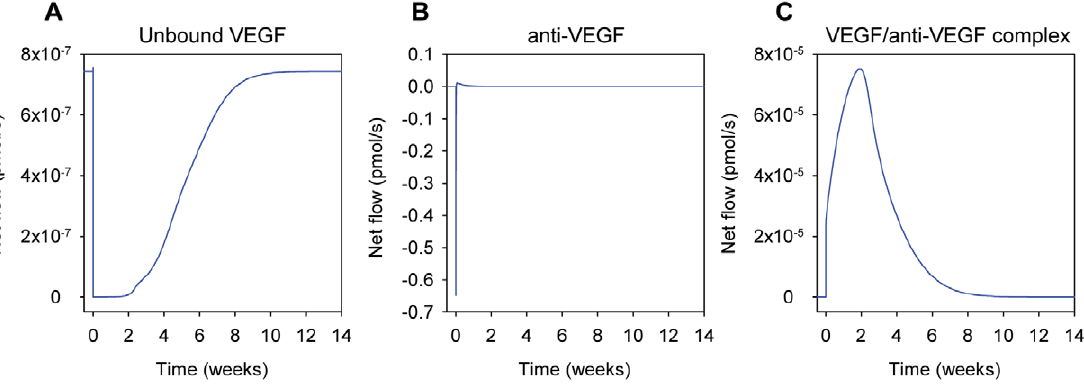
Figure 8. Intercompartmental flows following the intravenous injection of the anti-VEGF agent (VEGF Trap). Instantaneous net flow rates of (A) unbound VEGF, (B) anti-VEGF, and (C) VEGF/anti-VEGF complex are calculated upon a 25 mg/kg injection of anti-VEGF into the blood. A positive net flow indicates movement from the tissue into the blood via intravasation and lymphatics, and a negative net flow indicates movement from the blood into the tissue via extravasation. Note that the y-axes of the panels are on different scales.